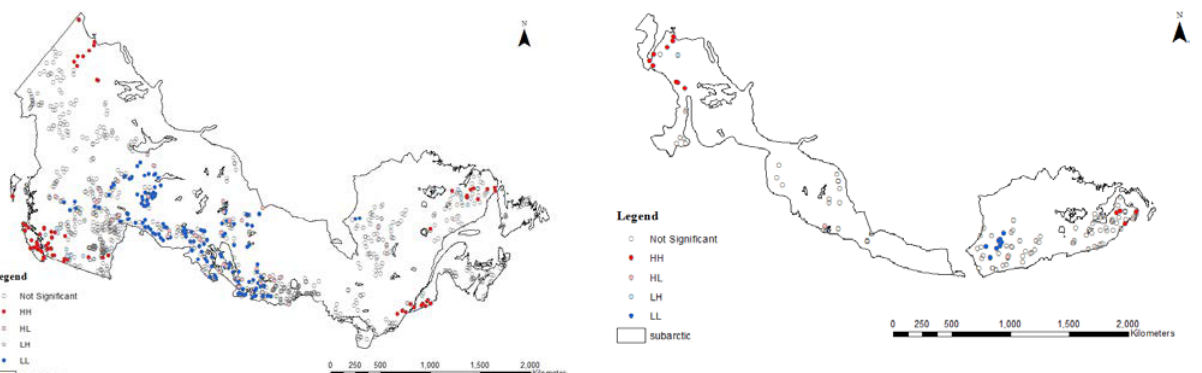
Figure 9. LISA cluster map of SOC distribution in the Subarctic eco-region with the Peel Watershed area labelled Figure 7. Local spatial autocorrelation (LISA) cluster map of SOC distribution at the national scale For the Boreal eco-region, as shown in Figure 10, LL patterns were mainly observed in western regions (e.g. Alberta, Most SOC LL clusters were located in central forest Saskatchewan, and Manitoba) and HH patterns in eastern ecosystems, suggesting that soils in these regions have regions. This spatial pattern is quite consistent with the comparatively low carbon stock compared to the rest of the precipitation regime and the forest age distribution characteristic study area. The LL clusters encompass the Western Boreal eco- of this region. Partly caused by the strong local variations in region, which has a drier and warmer climate compared to other SOC stock, the distribution of LL clusters was not eco-region classifications and consists of forest groups of a homogeneous with many HL outliers also prevalent. Western majority within the range of 10 years to 30 years (Figure 8). All Boreal areas experience a mixed forest age distribution, thus of these attributes potentially explain why lower SOC levels are different amounts of litterfall potentially result in variations in observed in this region. SOC stocks. Differences in other terrain attributes (e.g. drainage capacity) may also partly account for SOC variation.